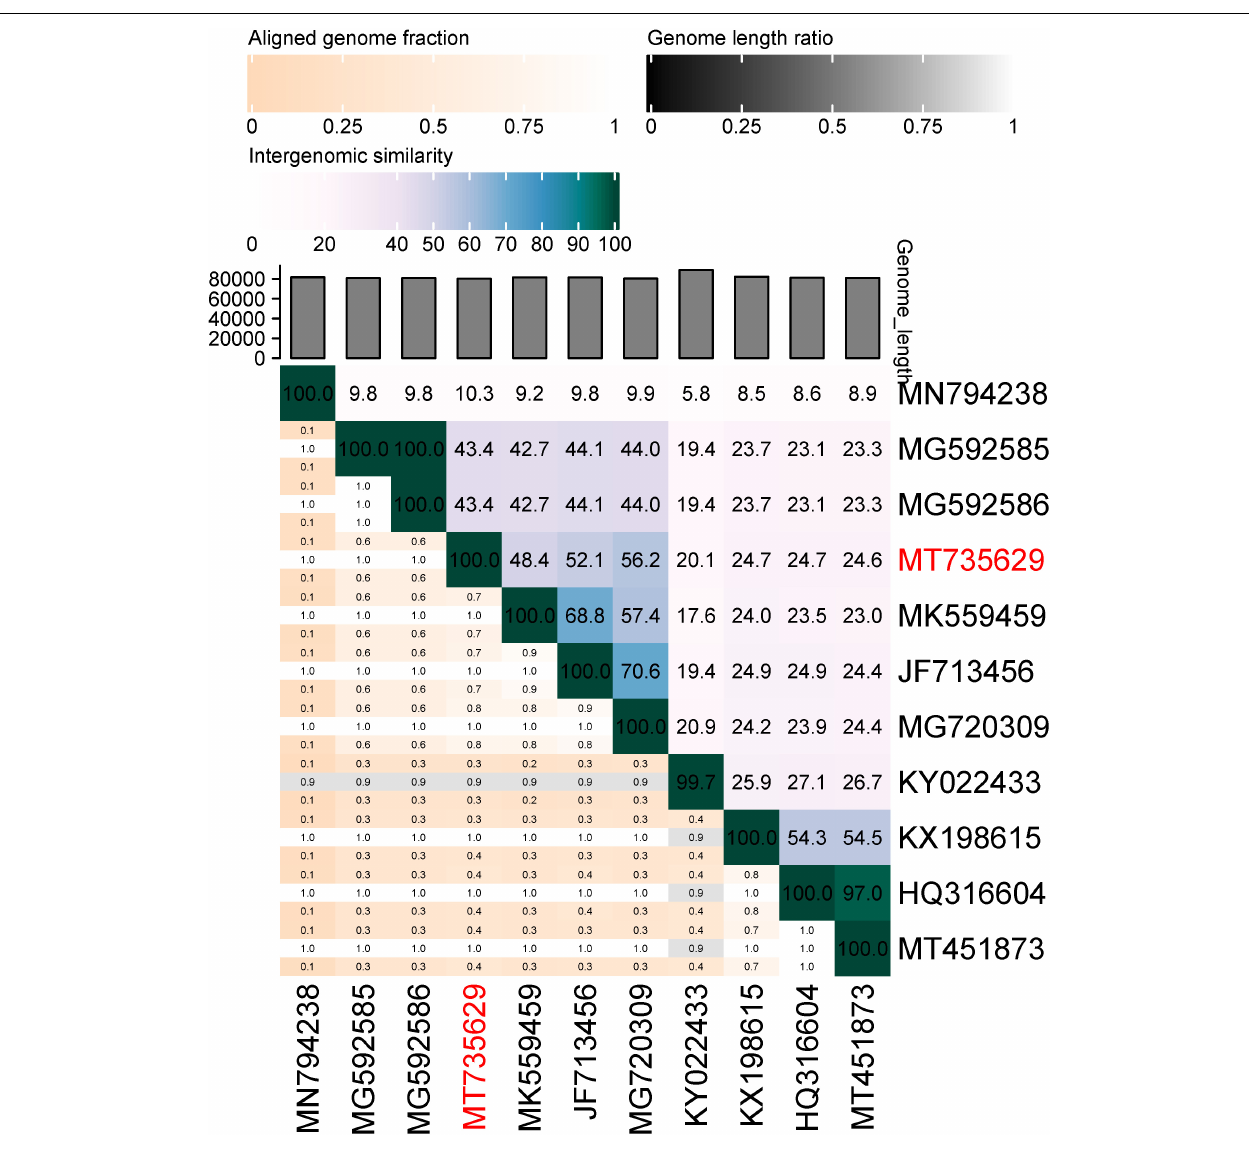
Frontiers in Microbiology |